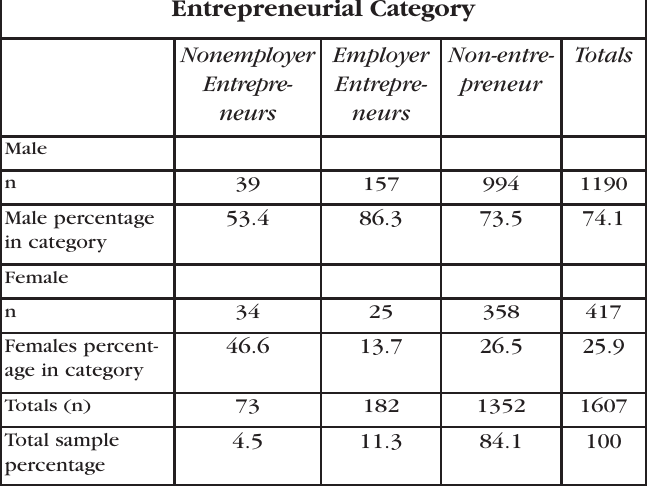
Table 3. Composition of Sample by Sex and